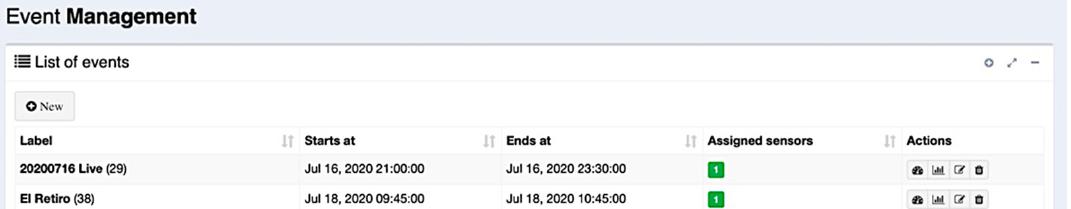
Figure 7. Event list view in the web application.